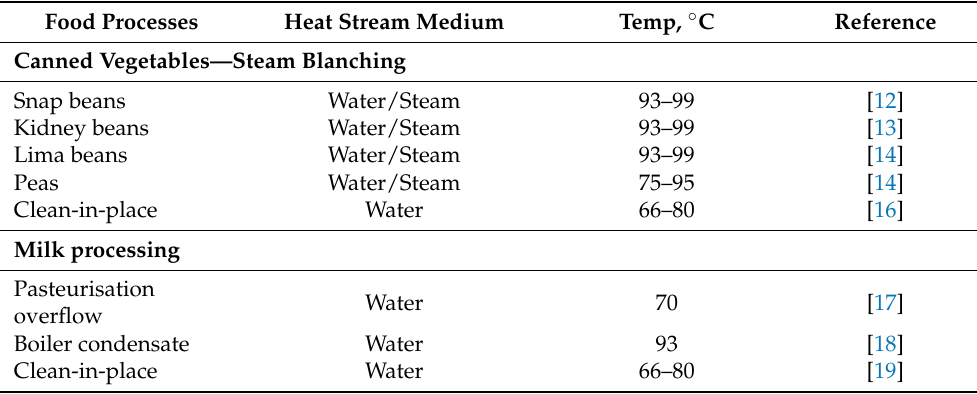
Table 1. Exemplified waste heat streams in the canning and dairy